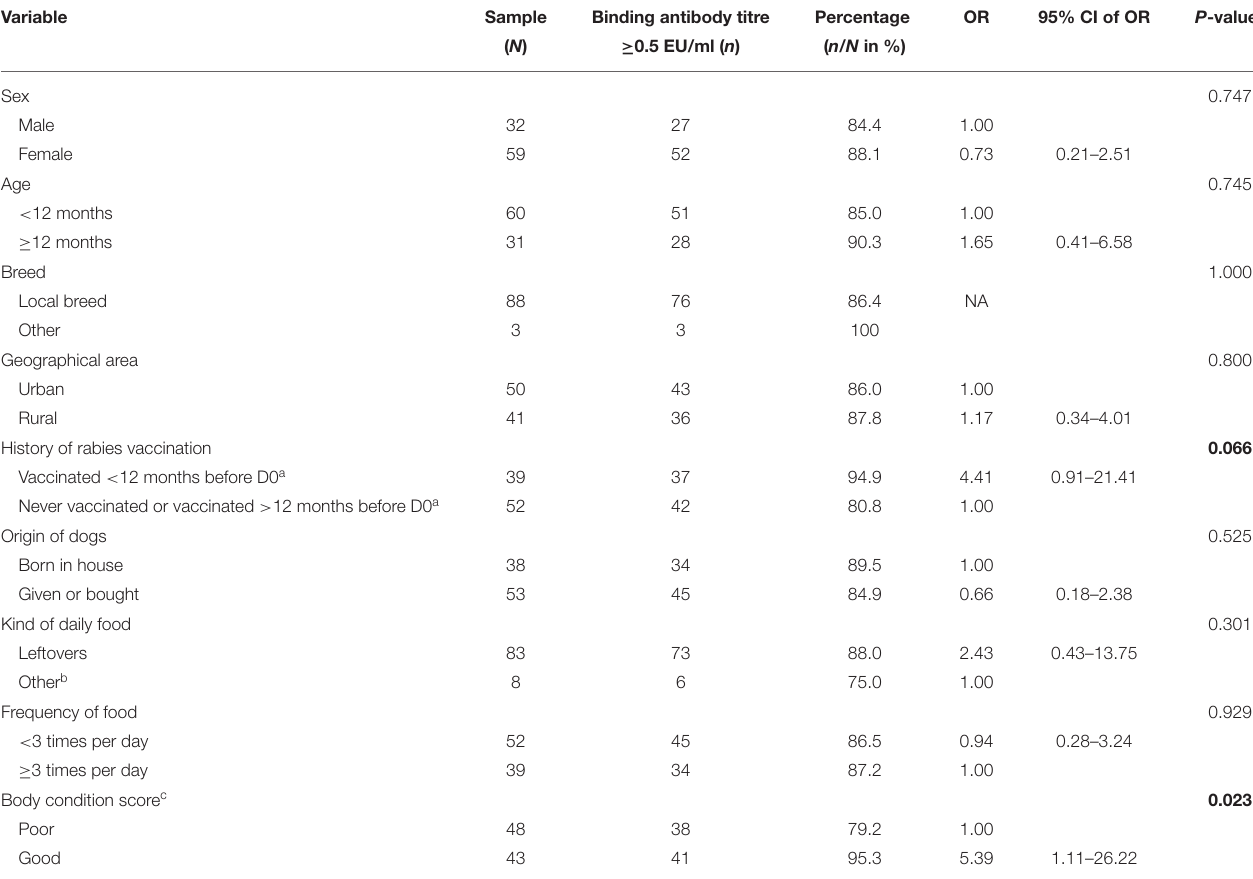
TABLE 4 | Frequency ( n ) and percentage ( n / N ) of dogs developing a level ≥ 0.5 EU/ml of binding antibodies within 30 days after vaccination, stratified by different demographic characteristics of the dogs.